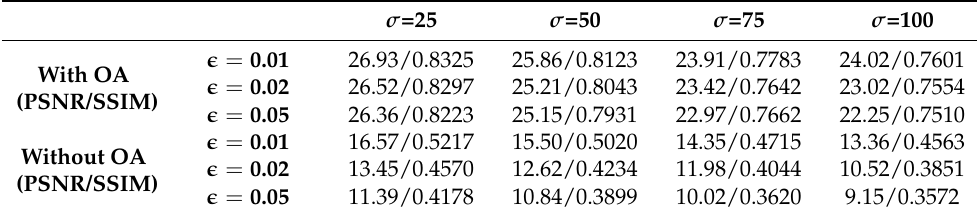
Table 4. Results of ablation experiments under PGD